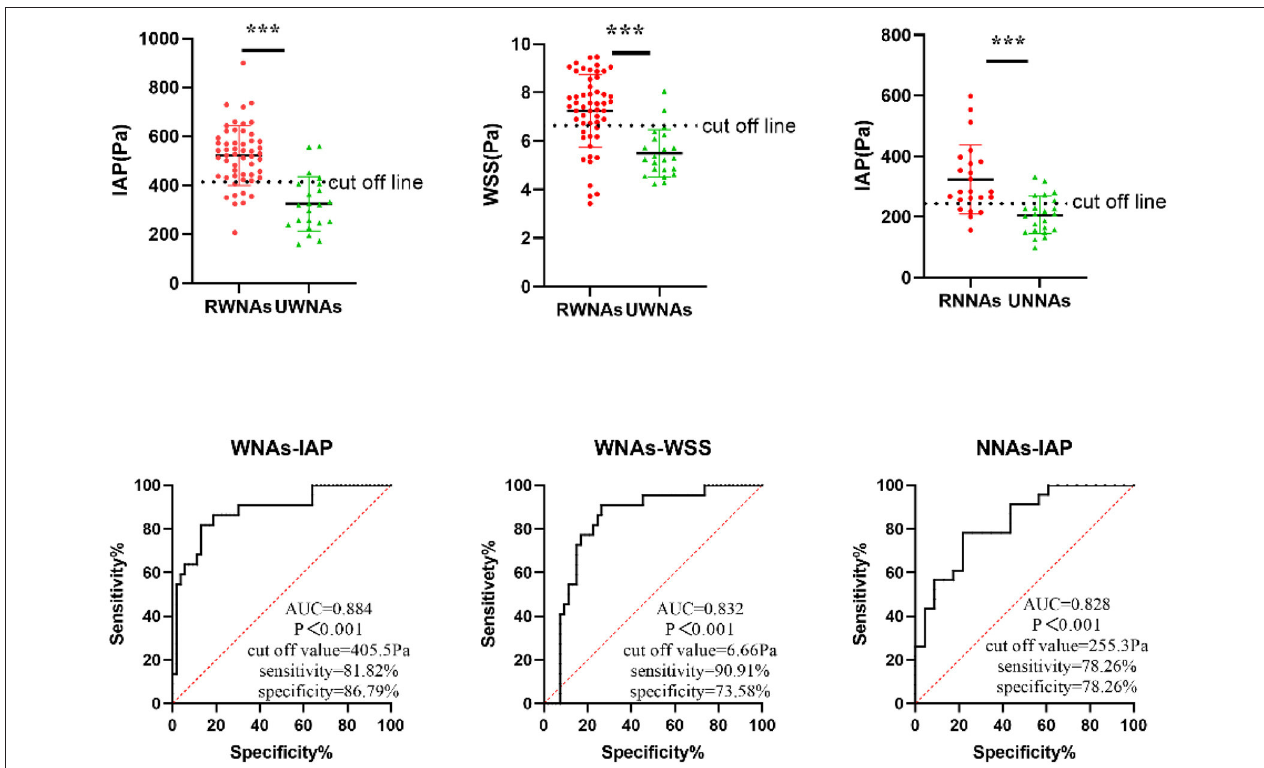
FIGURE 1 | ROC curve of independent predictive hemodynamic parameters for NNAs and WNAs rupture. *** means P < 0.001.